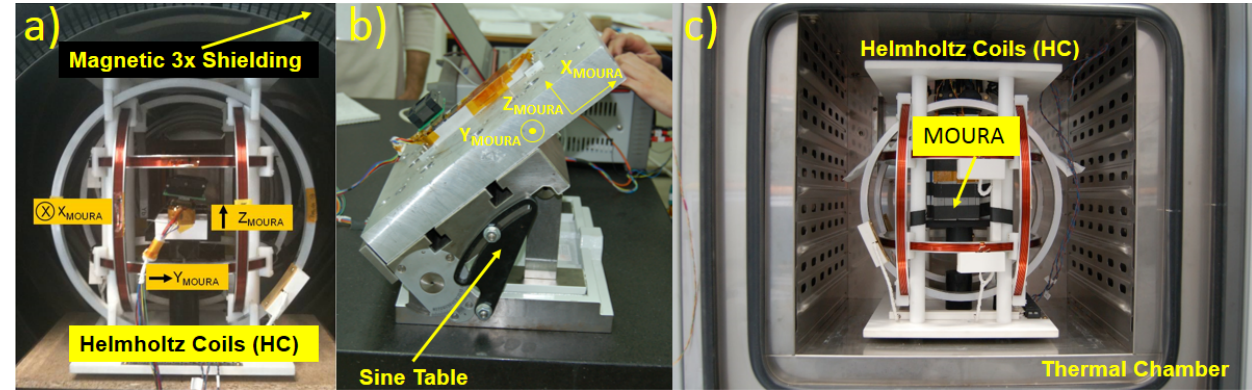
Figure 3. Different setups: (a) offset, gain and Euler angles characterization setup, (b) inclinometer characterization setup, (c) setup for gain characterization with